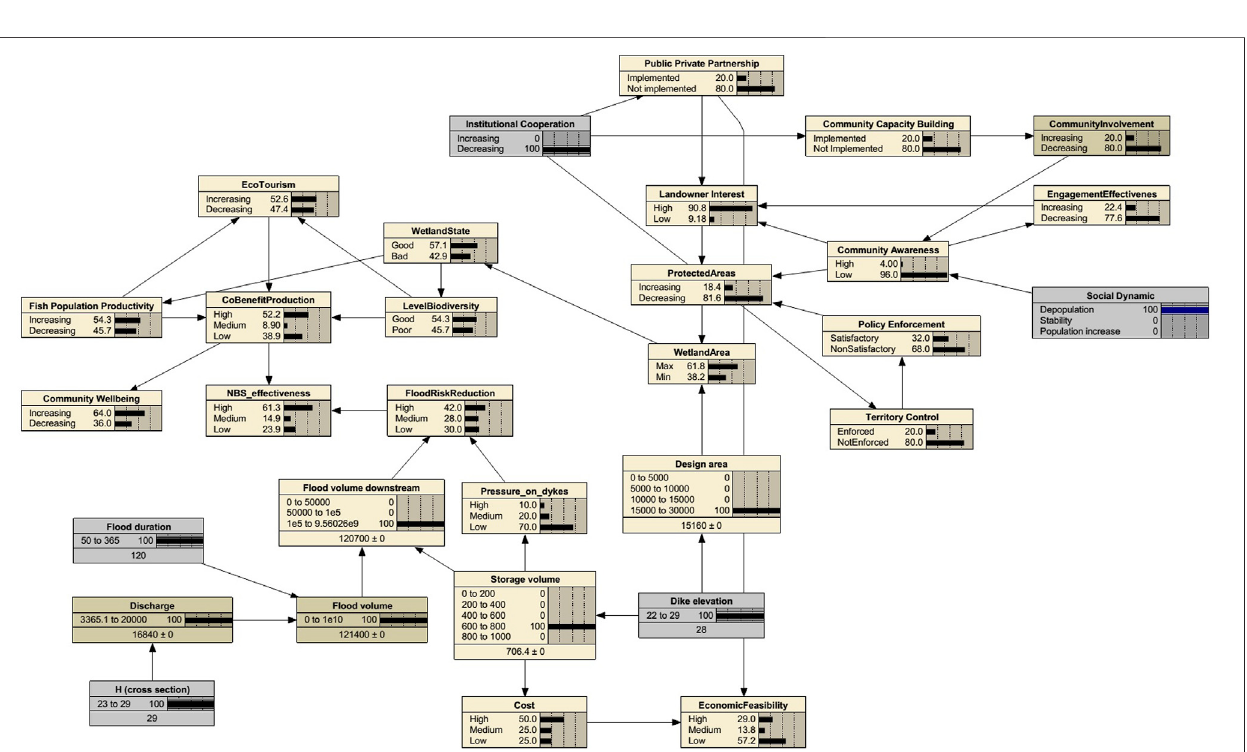
FIGURE 9 | Scenario analysis: 1) “ Current restoration ” scenario.